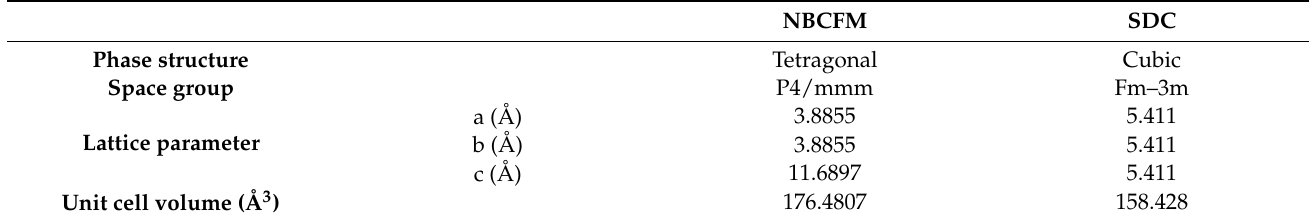
Figure 1. ( a ) X-ray patterns of SDC and NBCFM; ( b ) NBCFM crystal structure, ( c ) thermal expansion curves, and ( d ) impedance spectra at 650–800 ◦ C of NBCFM; inset is the enlarged impedance spectra at 750 ◦ C and 800 ◦ C. Table 1. The lattice parameters and the unit cell